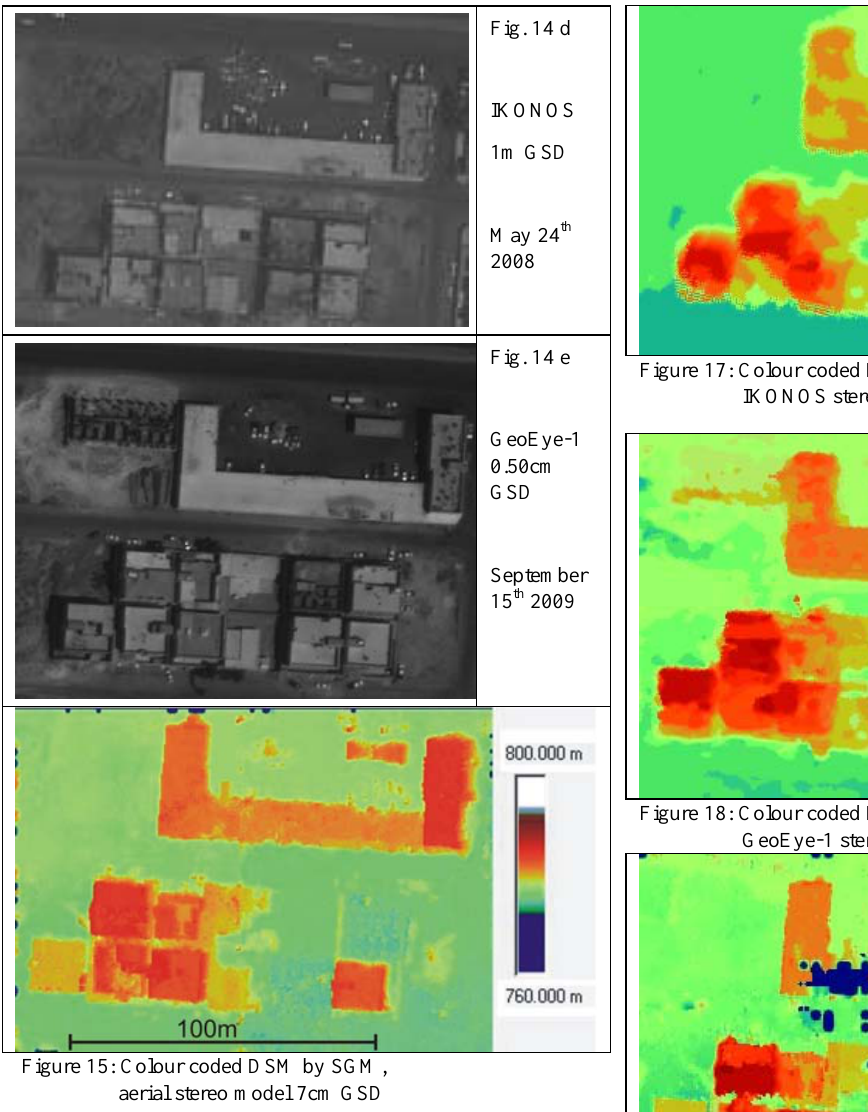
Figure 15: Colour coded DSM by SGM, aerial stereo model 7cm GSD